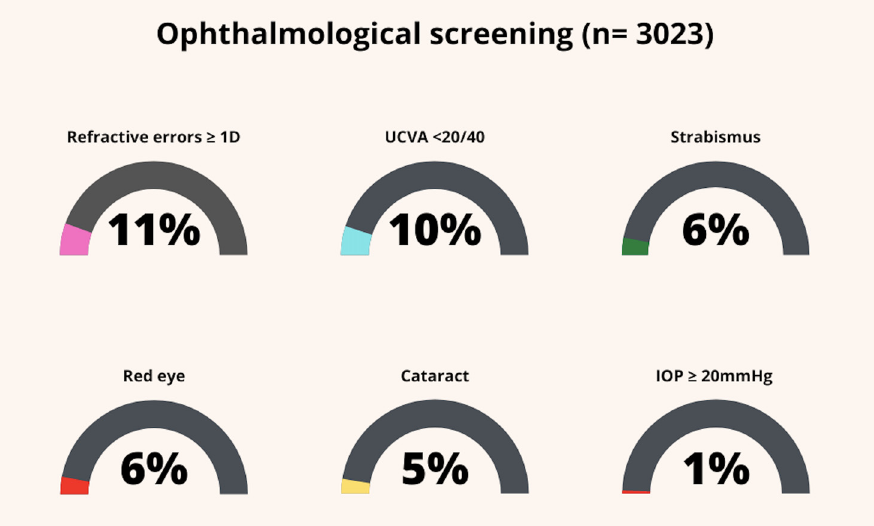
Figure 3. Principal findings of the ophthalmological screening within the PROTECT project. Of note, refractive error represented the main cause of vision impairment.